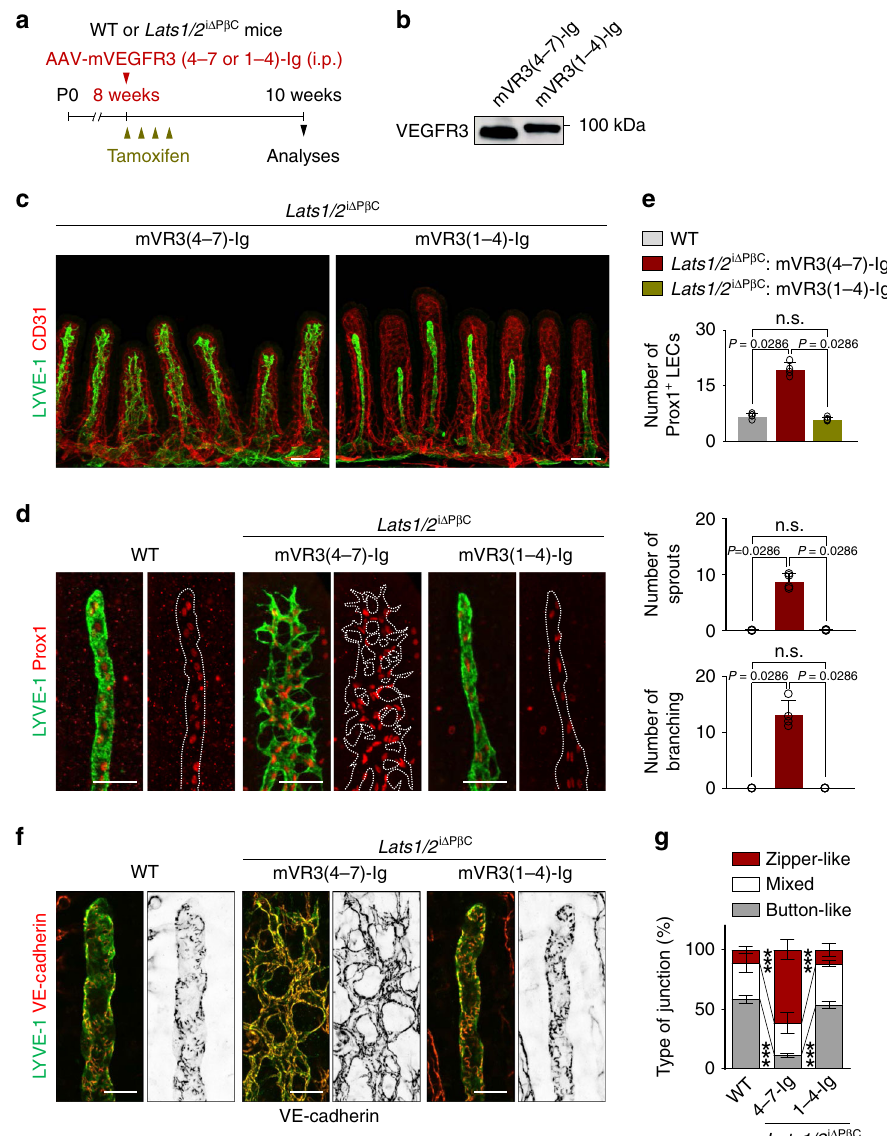
Fig. 3 VEGFR3 blockade abrogates lacteal sprouting and branching in Lats1/2 i Δ P β C mice. a Diagram for analyses of adult WT and Lats1/2 i Δ P β C mice two weeks after single intraperitoneal (i.p.) injection of AAV – mVEGFR3(4-7)-Ig (mVR3(4-7)-Ig, control) or AAV-mVEGFR3(1-4)-Ig (mVR3(1-4)-Ig, VEGFR3 blockade). b Representative immunoblot analysis showing mVEGFR3-Ig proteins in serum two weeks after single i.p. injection of AAV – mVEGFR3(4-7)-Ig or AAV-mVEGFR3(1-4)-Ig (1 × 1012 viral particles in 150 – 200 μ l PBS). kDa, kilodalton. Similar fi ndings were observed in n = 4 mice/group from two independent experiments. c – e Representative images of CD31 + capillary plexus and LYVE-1 + lacteals in the villi of Lats1/2 i Δ P β C mice treated with mVR3(4- 7)-Ig or mVR3(1-4)-Ig and comparisons of the number of Prox1 + lymphatic endothelial cells (LECs), lacteal sprouts, and lacteal branches of LYVE-1 + lacteals per 100 μ m of lacteal length in the villi of WT and Lats1/2 i Δ P β C mice treated with mVR3(4-7)-Ig or mVR3(1-4)-Ig. White dotted-line outlines the lacteal. Each dot indicates a mean value of 10 – 20 villi/mouse and n = 5 mice/group pooled from two independent experiments. Horizontal bars indicate mean ± SD and P value versus WT or mVR3(4-7)-Ig by two-tailed Mann – Whitney U test. n.s., not signi fi cant. Scale bars, c 100 μ m; d 50 μ m. f , g Representative images and comparison of VE-cadherin + LEC junctions of LYVE-1 + lacteals in the villi of WT and Lats1/2 i Δ P β C mice treated with mVR3 (4-7)-Ig or mVR3(1-4)-Ig. Horizontal bars of each colored segment represent mean ± SD of 5 – 10 villi/mouse and n = 5 mice/group pooled from two independent experiments. *** P < 0.0001 versus WT or mVR3(4-7)-Ig treated Lats1/2 i Δ P β C mice by two-way ANOVA with Holm – Sidak ’ s multiple comparisons test. Scale bars, 25 μ